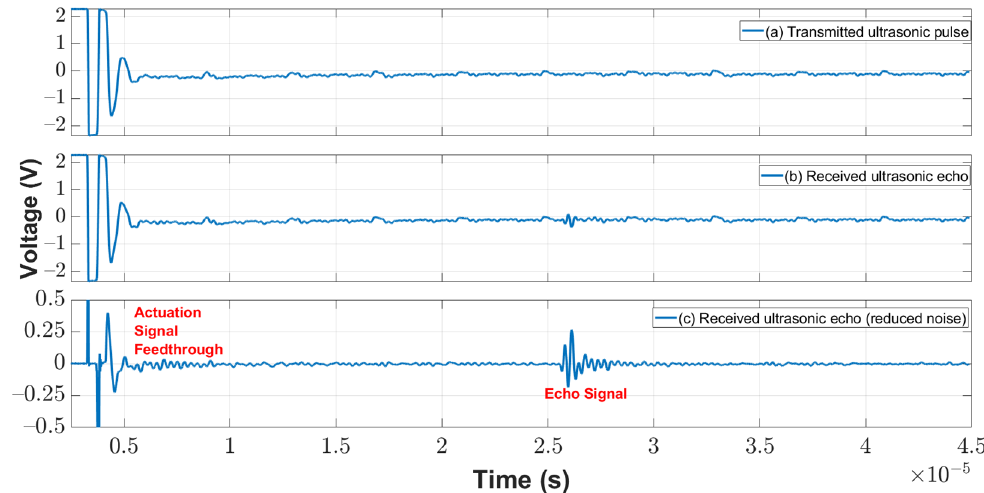
Figure 14. ( a ) Transmitted ultrasonic pulse, ( b ) received ultrasonic echo, and ( c ) the resultant subtraction is a reduced-noise version of the received echo.